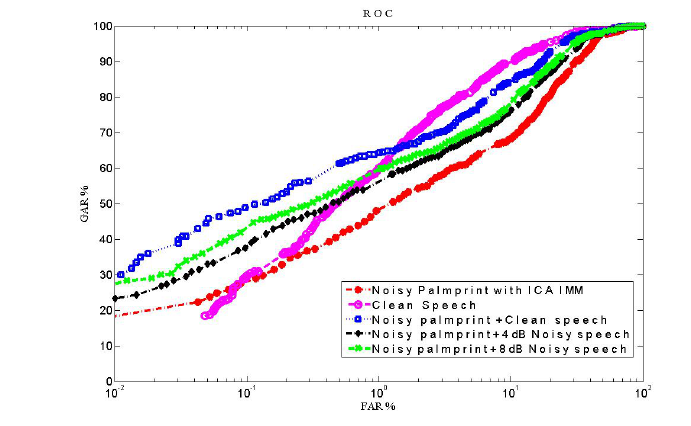
Figure 13. ROC curves for match score level fusion of noisy palmprint using ICA I MM with speech (both clean and